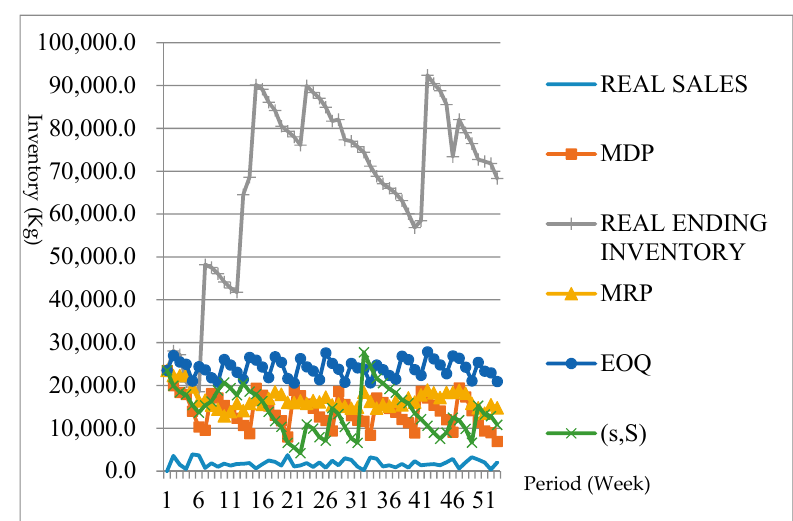
Figure 2. Inventory charts (period 165 to 216).